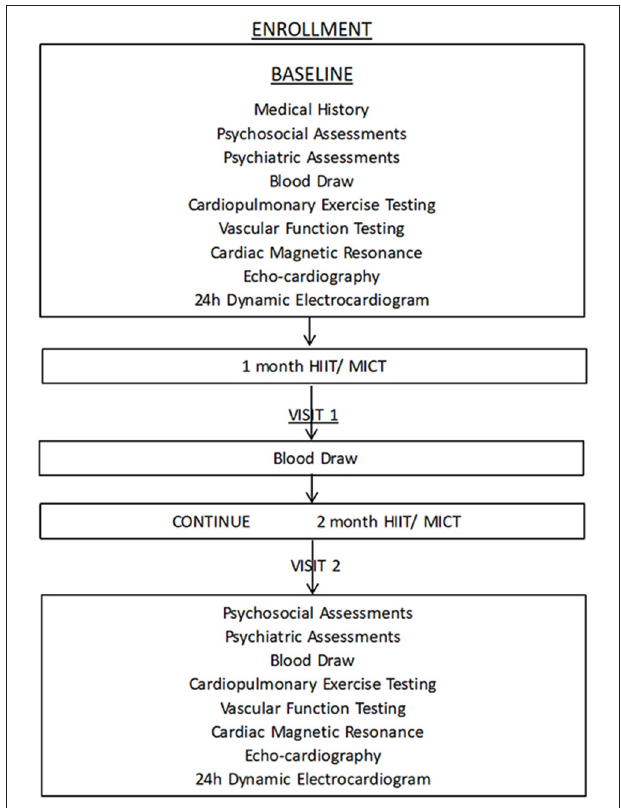
FIGURE 1 | The process of